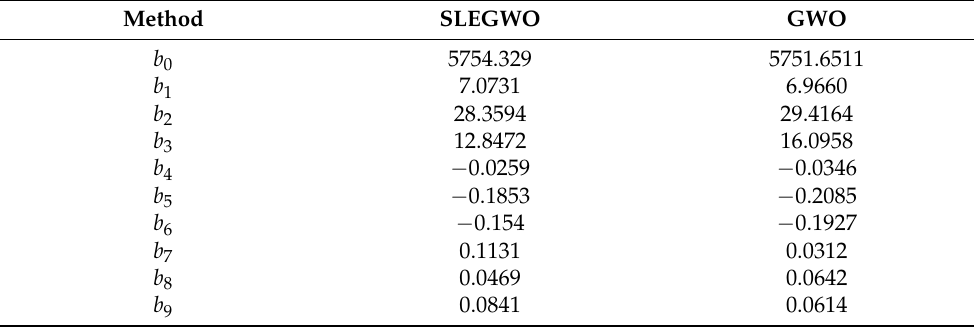
Table 5. Coefficients of fertilizer effect function obtained by different methods.